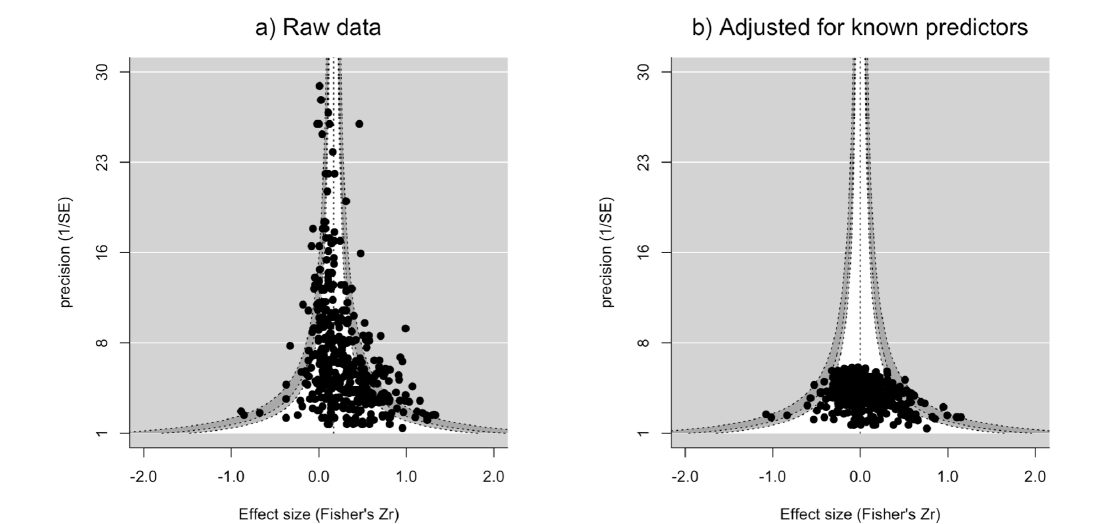
Figure 9. Funnel plots based on raw effect sizes (a) and effect sizes adjusted for known predictors (b). When accounting for the influence of which reproductive trait was measured, whether the species is a cooperative breeder or not, the number of litters per year the species produces, and the phylogenetic covariance among species, the distribution of the 444 effect sizes in our sample appears much less imbalanced (b) than the raw effect sizes (a). The mean effect size (grey dotted line in the center